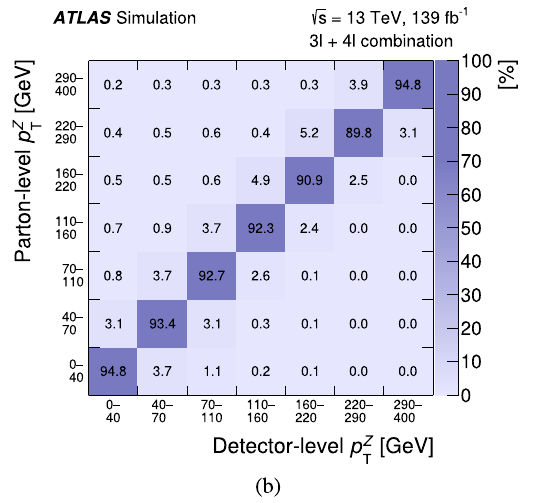
values are expressed as a percentage. The matrices are normalised such that the sum of any given row is 100%, although small differences may be present due to rounding